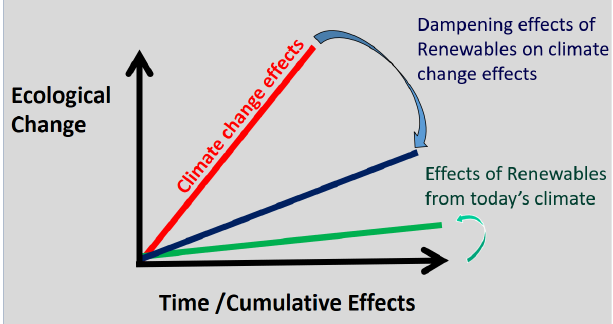
Fig. 4. The ecological effects of climate change (represented in red) are increasing rapidly with time. The level of ecological change that EIAs are assessing is represented with the green line and arrow. The positive impacts of renewable energy production in dampening the effects of climate change (shown with blue line and